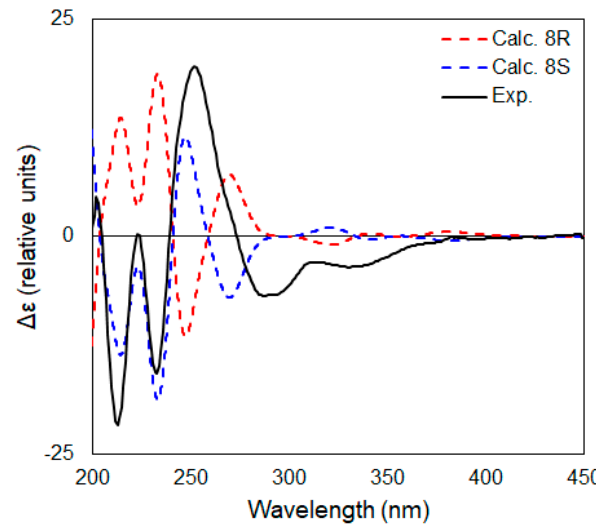
Figure 2. Comparison between the two TDDFT predicted electronic circular dichroism (ECD) spectra of both enantiomers of 1 and the experimental spectrum of 1 .